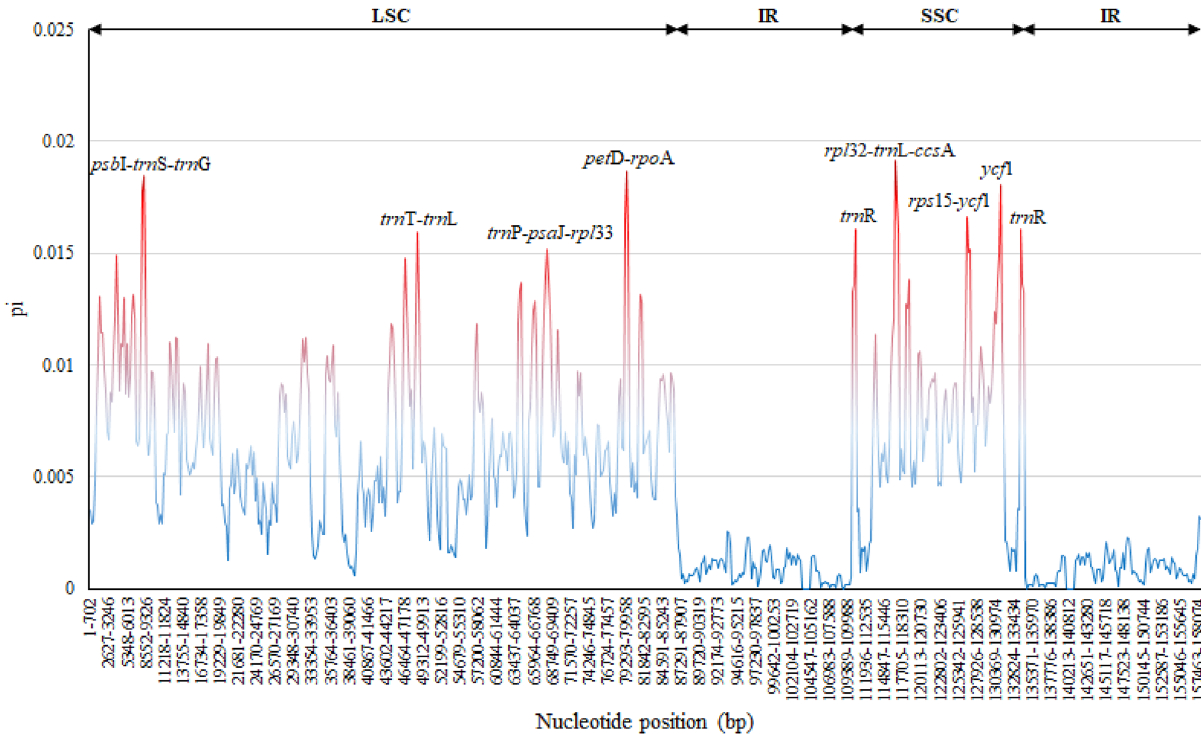
Figure 3. Sliding window analysis of 48 Lilium cp genomes (window length: 600 bp—step size: 200 bp). The X-axis and Y-axis represents the position of a window and nucleotide diversity (Pi) of each window,